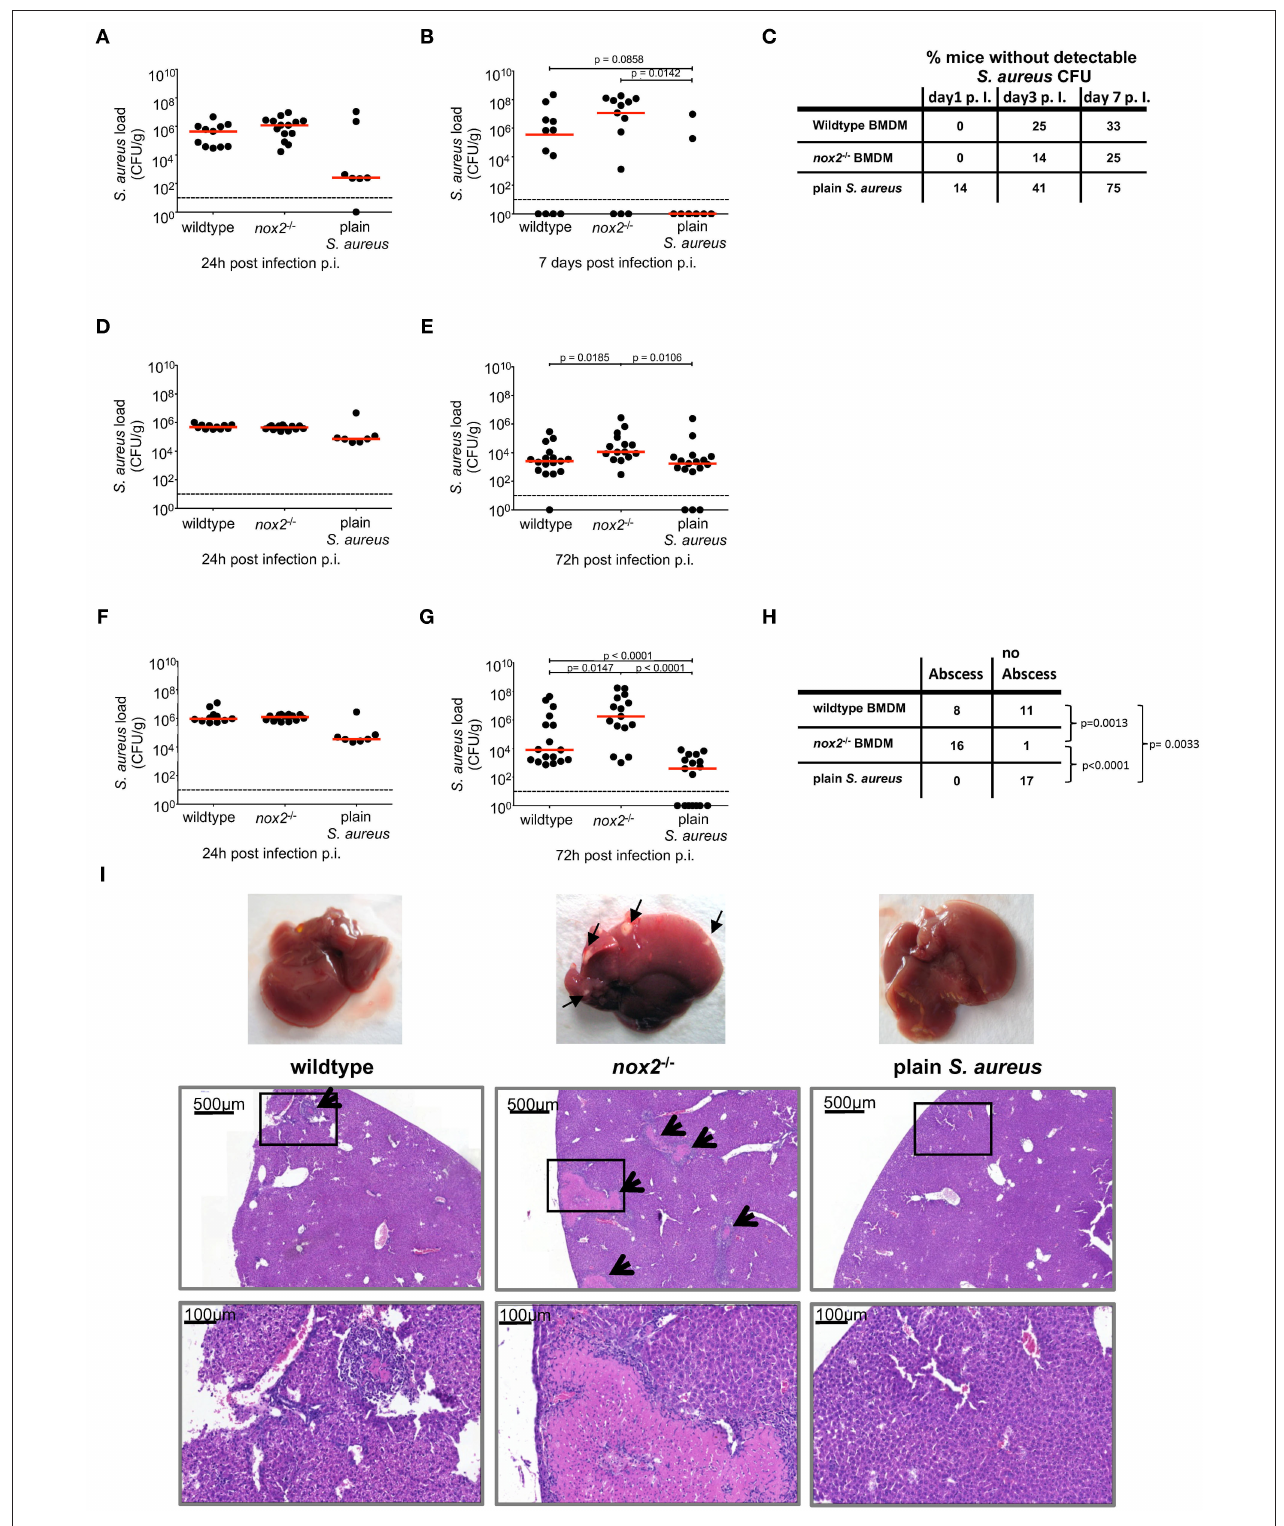
FIGURE 3 | Bacterial load in kidney, spleen and liver from mice upon injection of BMDM infected with S. aureus . BMDM of wildtype or nox2 − / − mice were infected with S. aureus MW2 GFP (MOI30) on day 8 post isolation from bone marrow. Upon infection 2.5 × 10 6 BMDM were injected in PBS intravenously into naive C57Bl6J mice. Mice injected with 4 × 10 6 plain S. aureus MW2 GFP, corresponding to the CFU recovered from infected BMDM served a control. Represented are individual